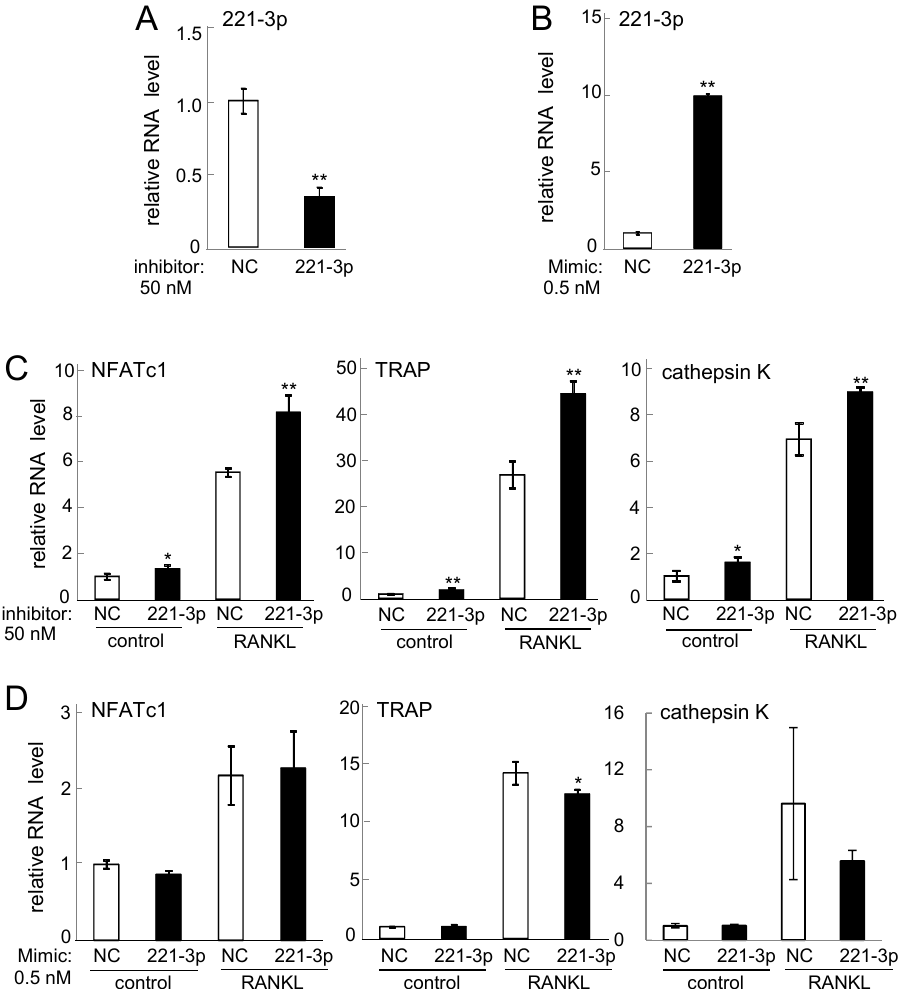
Figure 3. Effects of miR221-3p inhibitor and mimicking agent. Of note, 50 ng/mL RANKL was used for one day in ( C , D ). The sample number was three in ( A , B ), four in ( C ), and six in ( D ). NC = non-specific control. The single and double asterisks indicate p < 0.05 and p < 0.01, respectively. ( A ) miR-221-3p level in response to its inhibitor; ( B ) miR-221-3p level in response to its mimicking agent; ( C ) NFATc1, TRAP, and cathepsin K mRNA levels in response to miR-221-3p inhibitor; and ( D ) NFATc1, TRAP, and cathepsin K mRNA levels in response to miR-221-3p mimic.